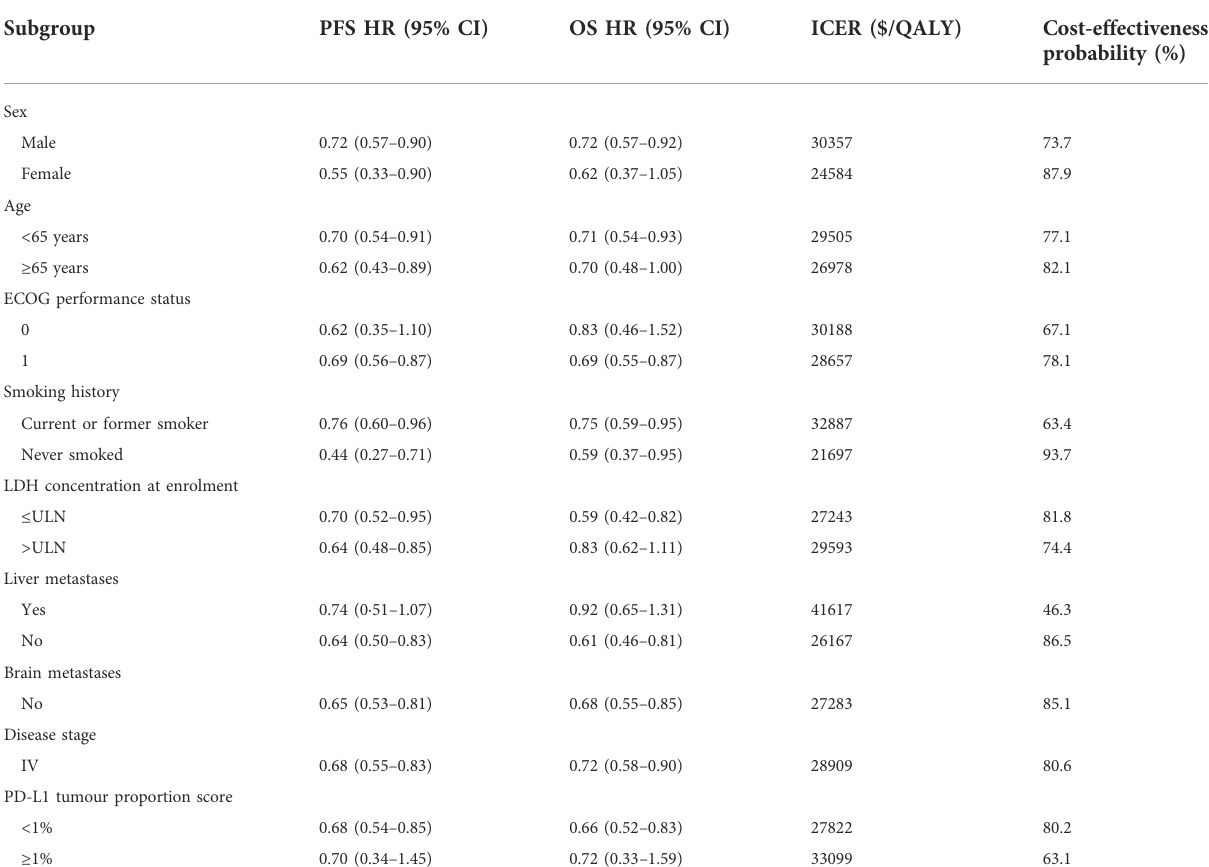
TABLE 2 Results of subgroup